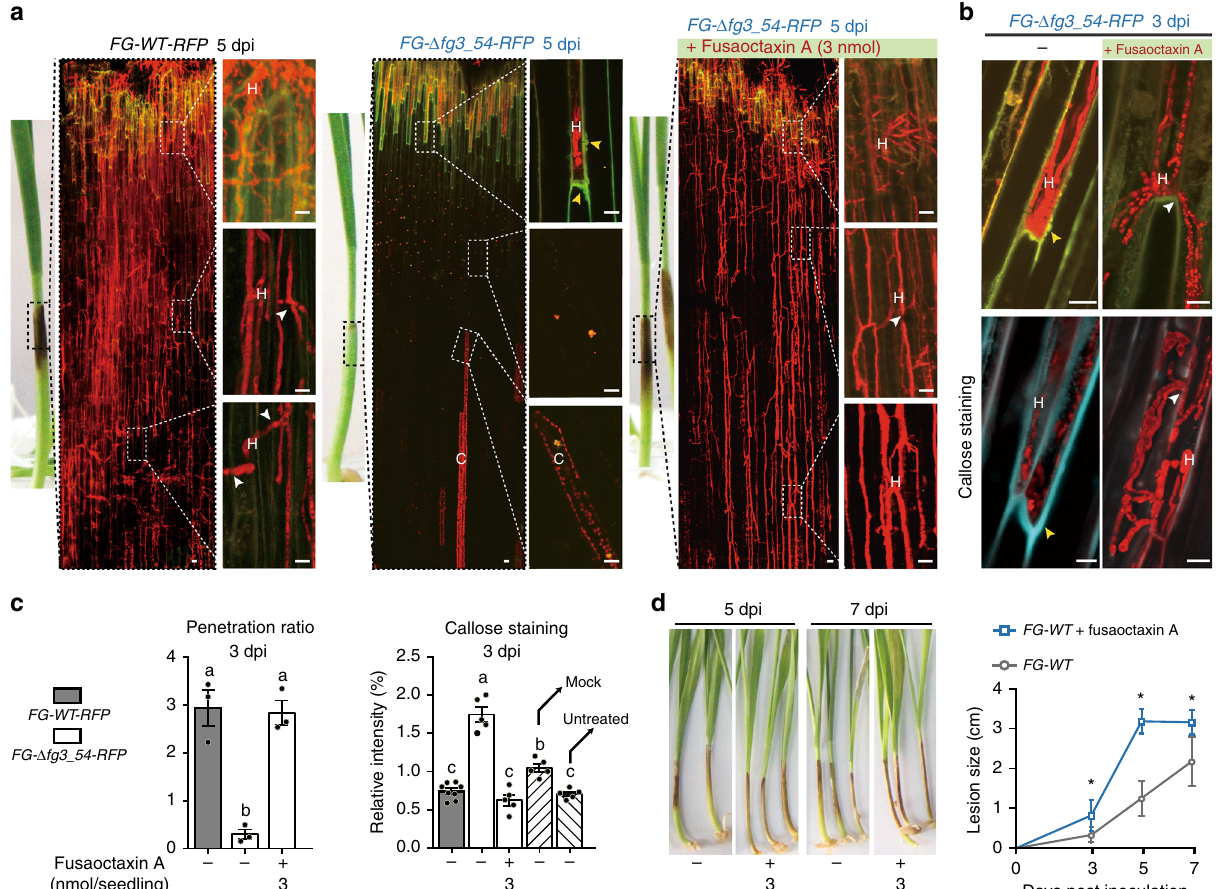
Fig. 6 Fusaoctaxin A can restore cell-to-cell invasion in mutants and enhance wild-type virulence in wheat. a Fluorescent microscopic images of wheat coleoptiles infected by the indicated strains. Images are overlay of RFP (fungal RFP and wheat chlorophyll auto fl uorescence) and GFP (plant cell wall auto fl uorescence) channels. b Confocal microscopic images of wheat coleoptile cells infected by indicated strains. The lower panel shows aniline blue staining (indicating the plant cell wall component callose) of these cells. H: F. graminearum hyphae. C: chlorophyll. The white arrowheads indicate hyphal penetration of plant cell wall. Scale bar = 20 μ m. c Measurements of the penetration ratio and callose staining intensities of wheat coleoptile infection. Data are means ± s.e.m. Different letters indicate a signi fi cant difference ( P < 0.05) based on one-way ANOVA followed by Tukey ’ s multiple comparison test. ( F = 32.13 df = 2, P = 0.0006; F = 58.7 df = 4, P < 0.0001). d Measurements and representative images of lesions on wheat seedling coleoptiles infected by wild-type F. graminearum with or without fusaoctaxin A. Data are mean ± s.d. Asterisks indicate a signi fi cant difference compared with FG-WT according to the two-tailed unpaired Student ’ s t -test (* P < 0.05; ** P < 0.01). Source data are provided in Supplementary Data